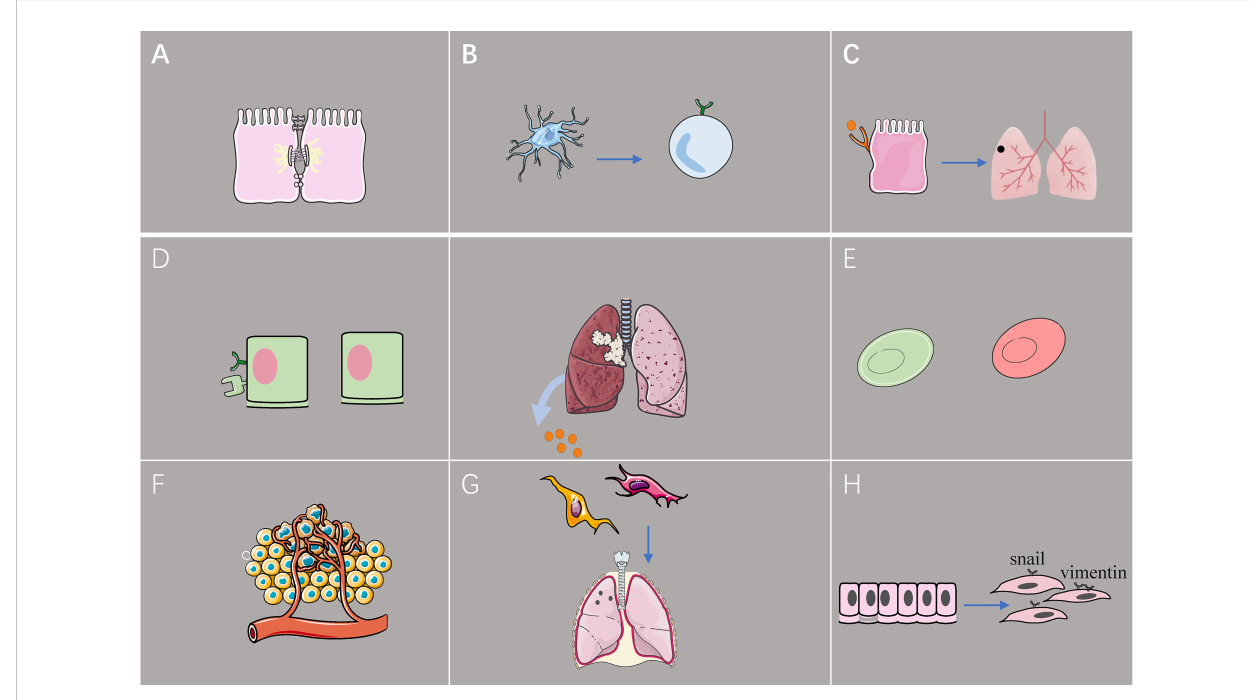
FIGURE 2 The effect of exosome from lung cancer cell on TME. (A) Exosomal miR-23a inhibits the tight junction protein ZO-1, increases vascular permeability, and promotes cancer cell migration. (B) Tumor-derived exosomes reduce programmed death-ligand 1 expression in dendritic cells, leading to downregulation of the population of regulatory T cells in vitro . (C) Lung epithelial cells sense tumor exosomal RNA via Toll-like receptor 3 and promote the formation of pulmonary pre-metastatic niches. (D) Hypoxic lung cancer cells promote M2 macrophage polarization by secreting excessive amounts of exosomal miR-21. (E) Exosomes induce early glycolytic reactions, thereby lowering the pH of the tumor microenvironment and promoting macrophage activation. (F) Upregulation of exosomal miR-210 promotes human umbilical vein endothelial cells and leads to increased tumor angiogenesis. (G) Exosomes promote the conversion of fi broblasts to tumor-associated fi broblasts, and exosomes from tumor- associated fi broblasts induce the formation of pre-metastatic niches in the lungs of mice. (H) Exosomes acquired from the sera of patients with advanced lung cancer have increased expression of vimentin and trigger epithelial-to-mesenchymal transition of lung cancer